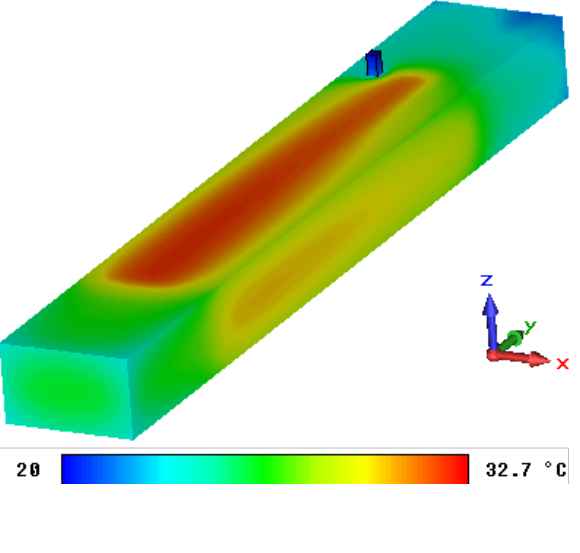
Figure 19. Temperature field based on coil